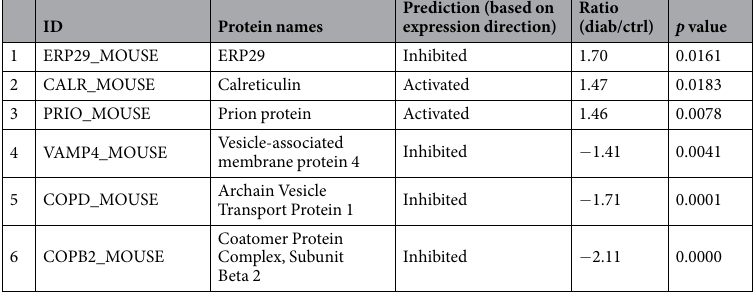
Table 2. Altered MAM proteins involved in the XBP1 pathway.